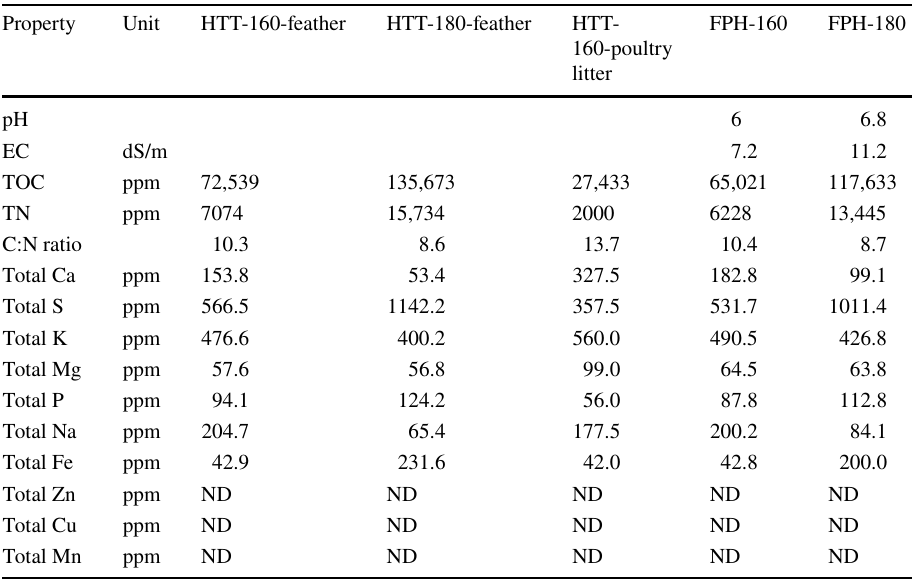
Table 2 Main characteristics of the produced